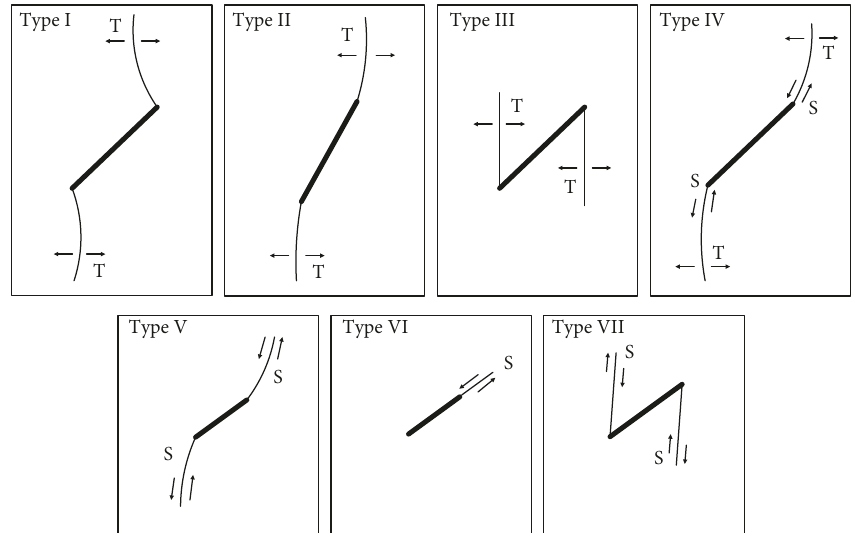
Figure 10: Various crack types initiated from the pre-cracks identified in the present studies (Tand S denote tensile and shear cracks).Type I: tensile crack; Type II: tensile crack; Type III: tensile crack; Type IV: mixed tensile-shear crack; Type V: shear crack; Type VI: shear crack (coplanar or quasi-coplanar shear crack); Type VII: shear crack (oblique shear crack) [1,